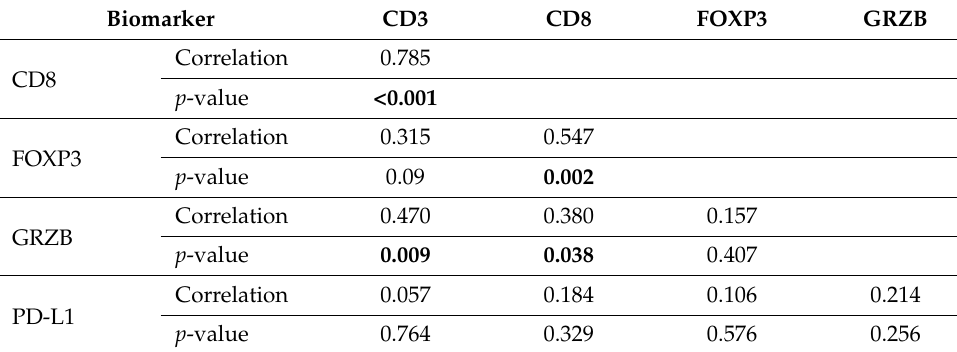
Table 4. Spearman’s rank correlation coefficient. Correlations between the expressions of single markers with each other.